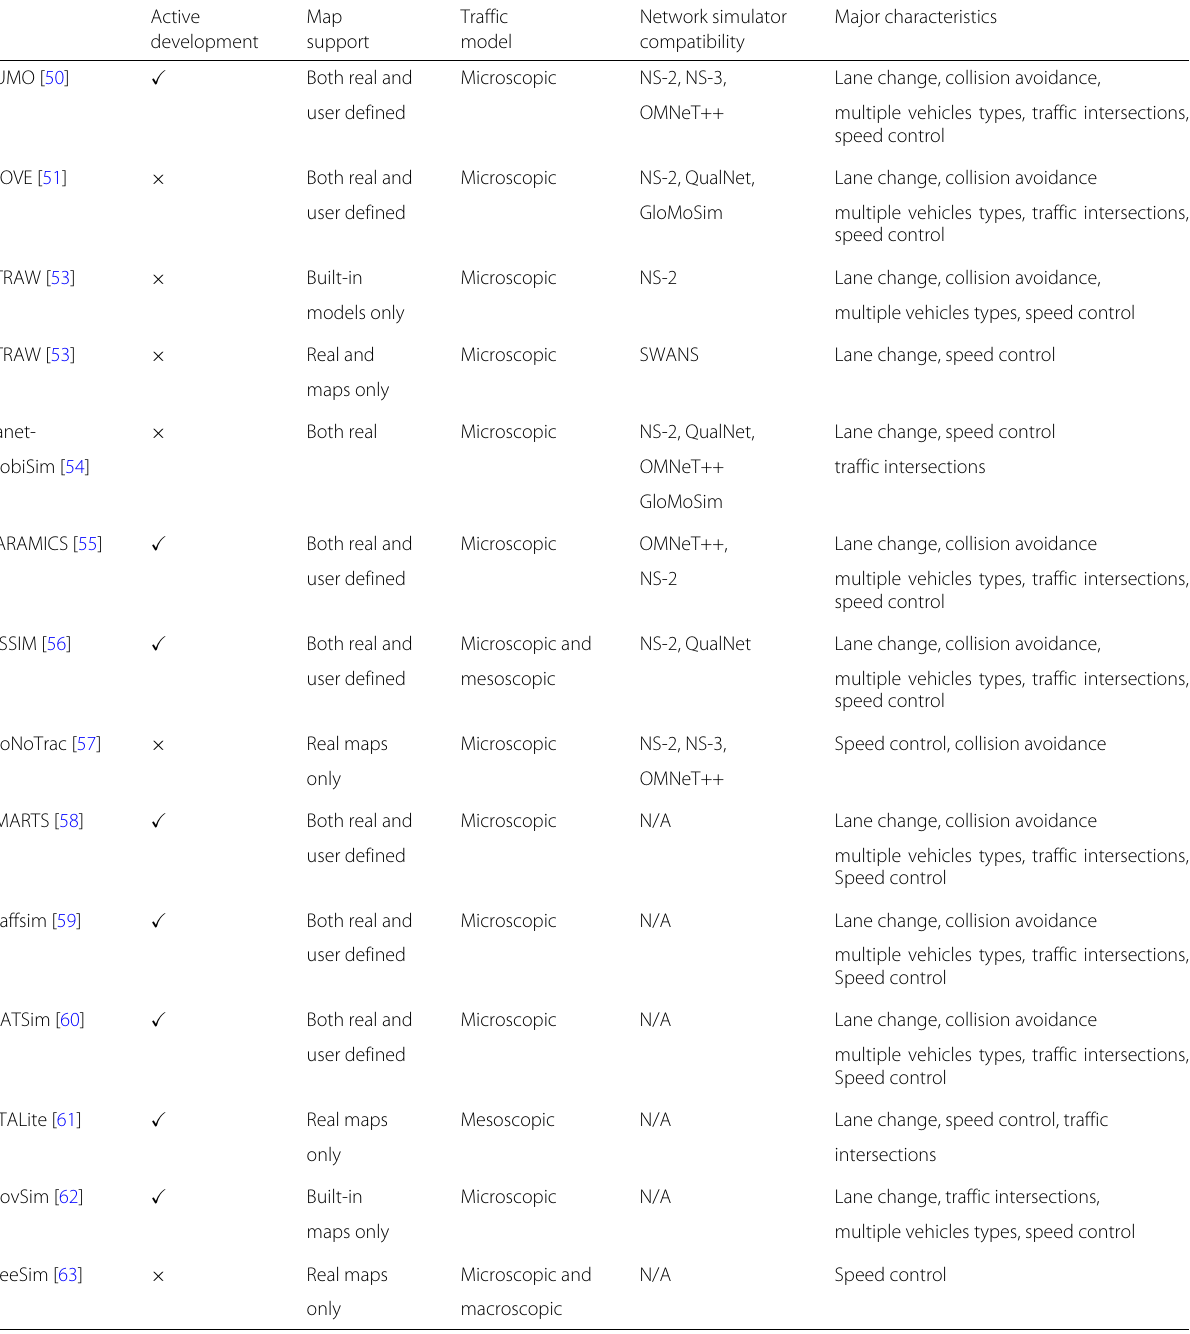
Table 1 Mobility generators